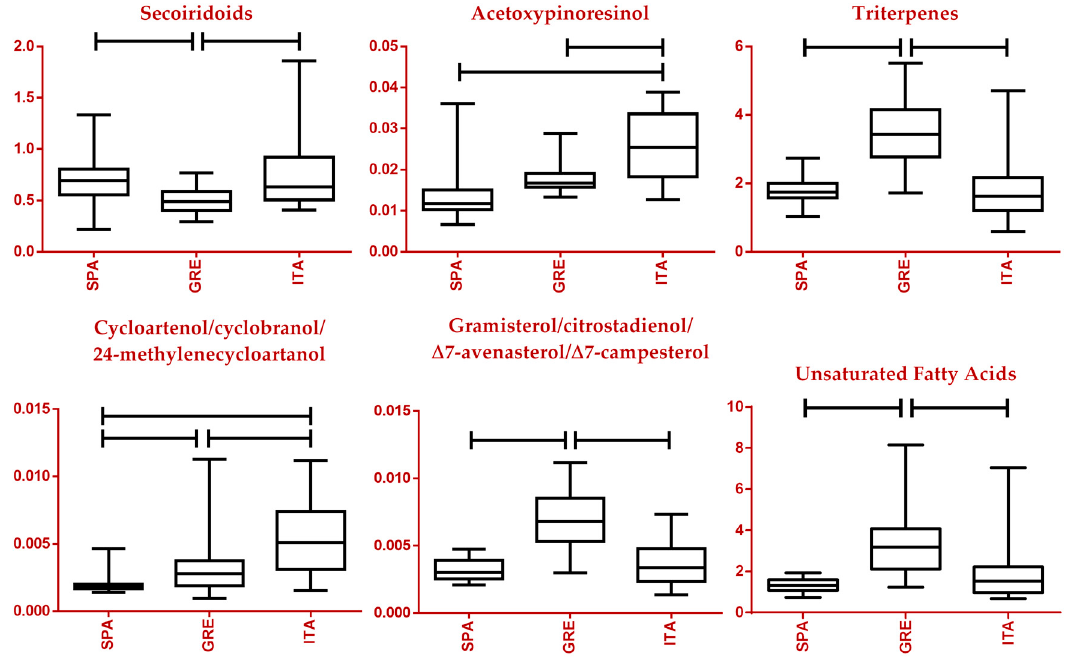
Figure 8. Box plots of a selection of statistically significant markers in the European sample set. Specifically, Secoiridoids, Acetoxypinoresinol, Terpenoids, Cycloartenol/Cyclobranol/24-methylenecycloartanol, Gramisterol/Citrostadienol/ ∆ 7-Avenasterol/ ∆ 7-Campesterol, and UFAs are depicted (vertical axis expressed in normalized intensity). Horizontal lines between classes indicate a p -value lower than 0.05. SPA: Spain, GRE: Greece, ITA: Italy.